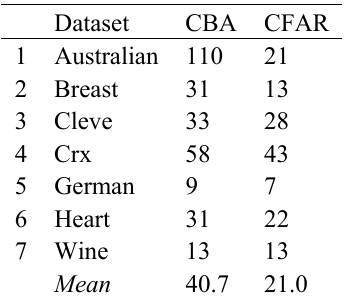
Table 13: Number of rules generated